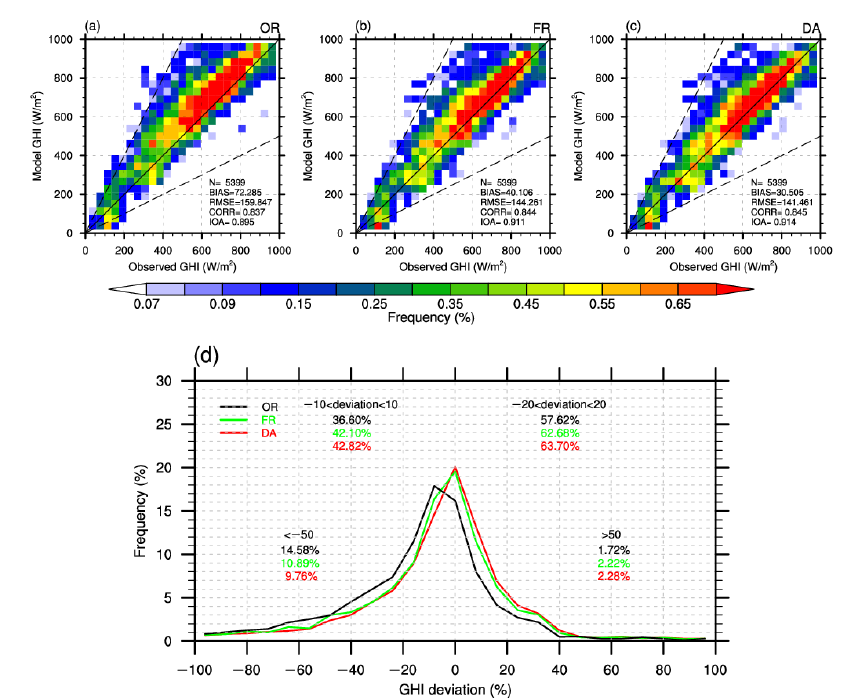
Figure 8. Probability density distribution of the observed versus the simulated hourly GHI under clear skies for the ( a ) OR, ( b ) FR and ( c ) DA experiments from 8 to 22 March 2021, only rural and suburban stations are analyzed. The continuous black line is the 1:1 line, and the dashed black lines correspond to the 1:2 and 2:1 lines. ( d ) Frequency distributions of deviations (modeled GHI minus observed GHI under clear skies) from the observations. The percentages of deviations between ±0.05, ±0.1, < − 0.5, and >0.5 are also shown.